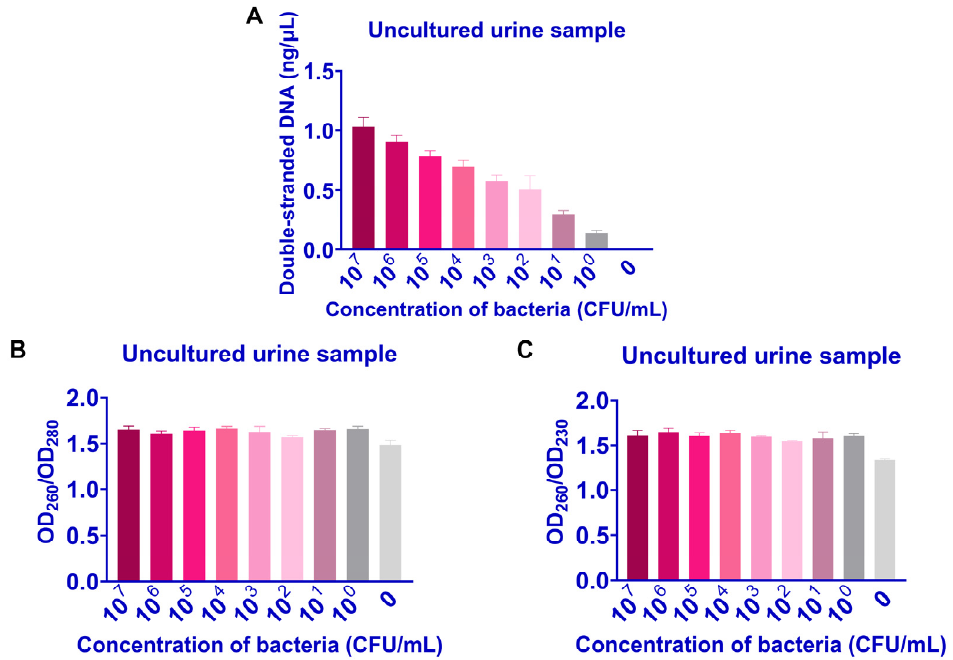
Figure 2. Feasibility of bacterial DNA extraction from uncultured bacterial-containing urine samples by refined Chelex-100 lysis method. ( A ) DNA concentration, ( B ) OD 260 /OD 280 value, ( C ) OD 260 /OD 230 value.